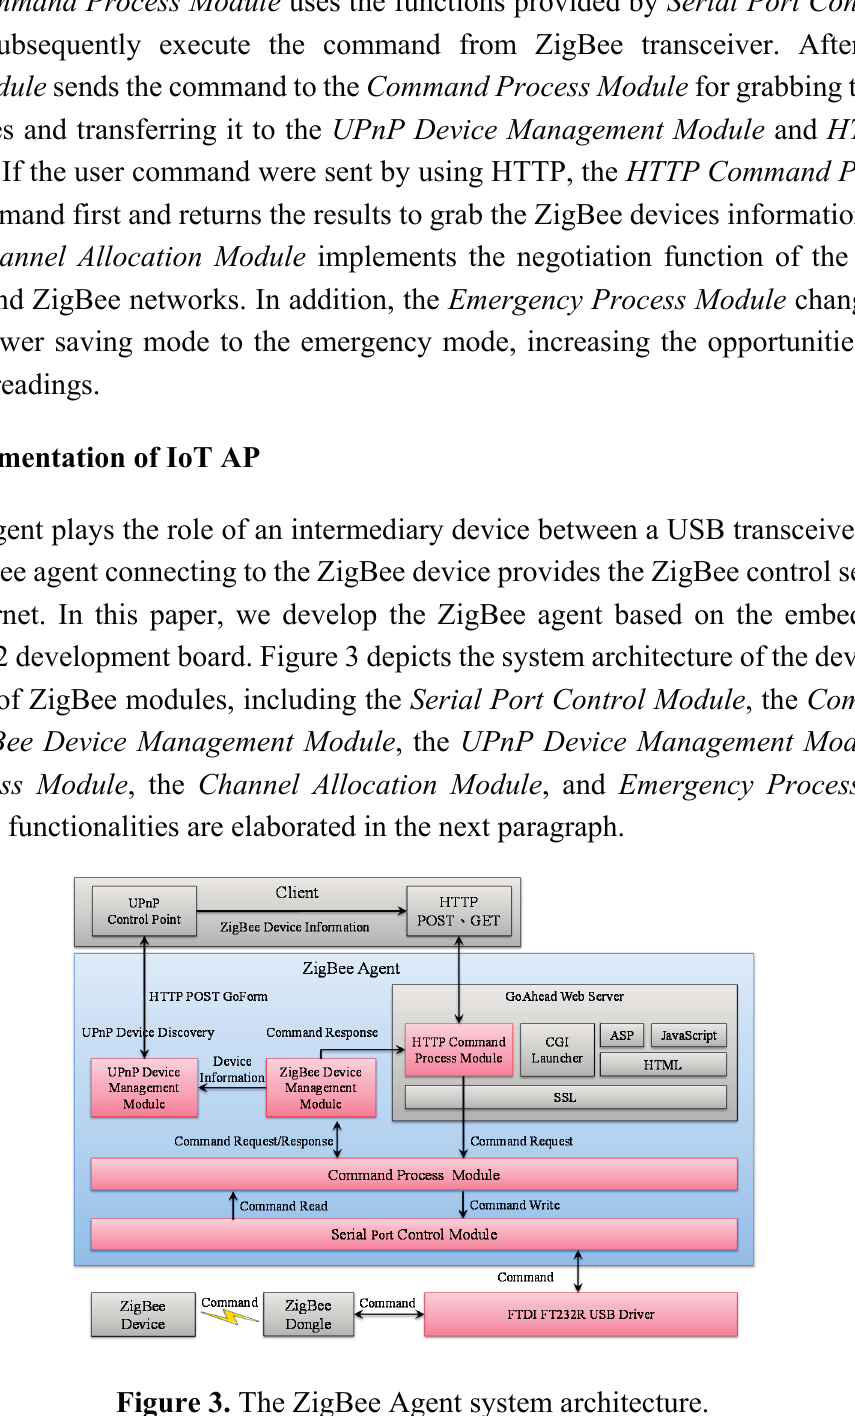
Figure 3. The ZigBee Agent system